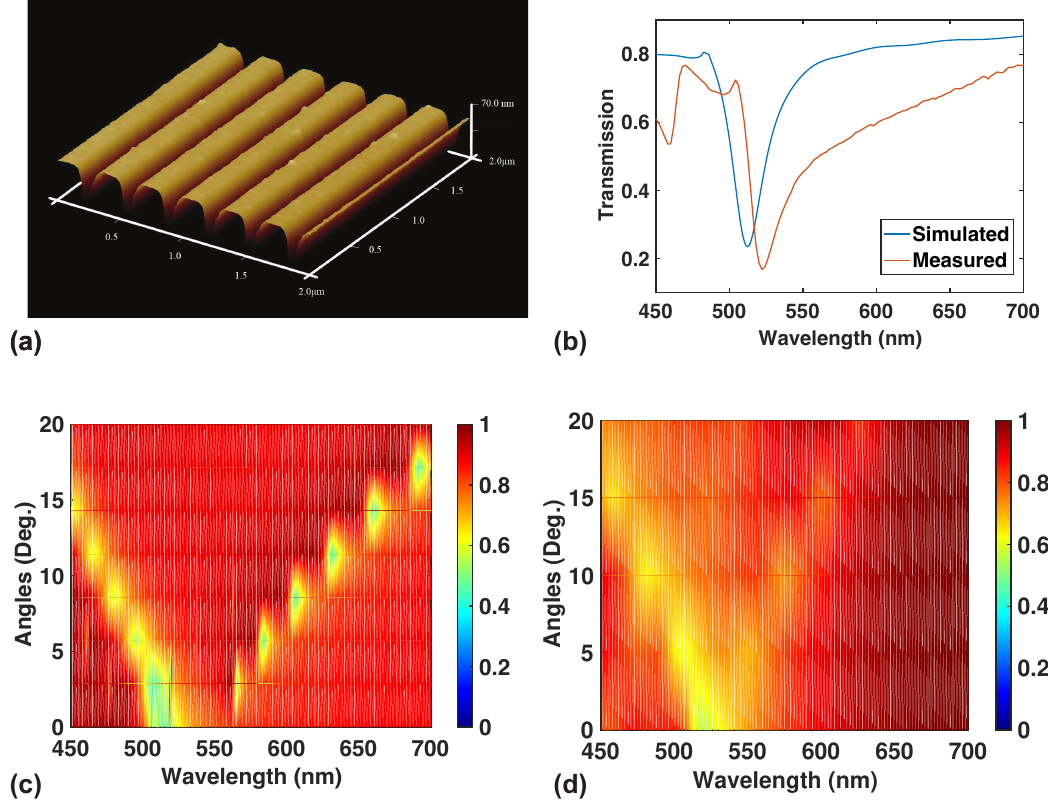
Figure 2. ( a ) Atomic Force Microscope (AFM) image of a fabricated sample. The height of the lines are measured to the around 60 nm while the period of the samples have been measured to be around 320 nm. ( b ) Comparison of p-polarized transmission versus wavelength at zero-angle from experiment and simulation. ( c ) Unpolarized simulation of transmission of a sample with the same dimensions as ( a ). ( d ) Measured transmission as a function of angle and wavelength with unpolarized source. It can be seen that ( c , d ) are in relatively good agreement with each